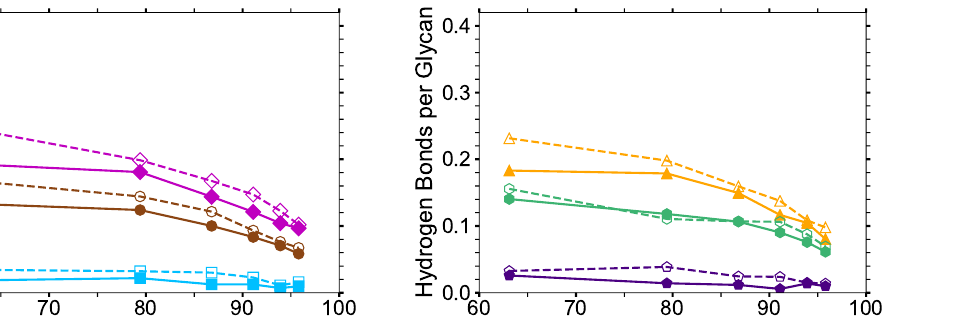
( a ) Cl-strand : first (dark pink) and second layer strands (brown and light blue).